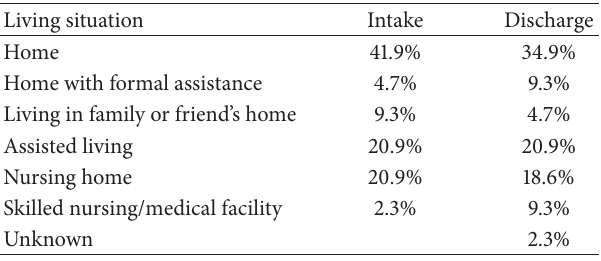
Table 2: Intake and discharge living